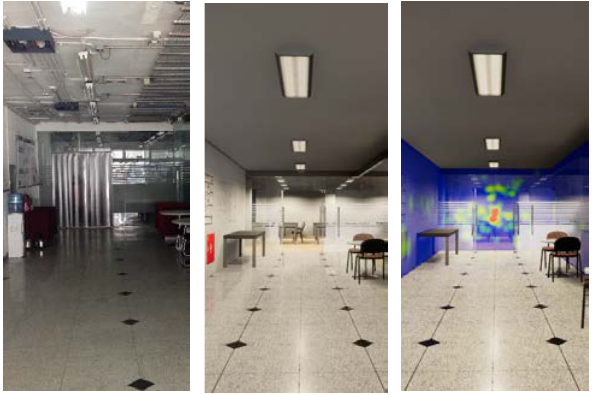
Figure 2: Actual atrium, its virtual reproduction and eye- tracking